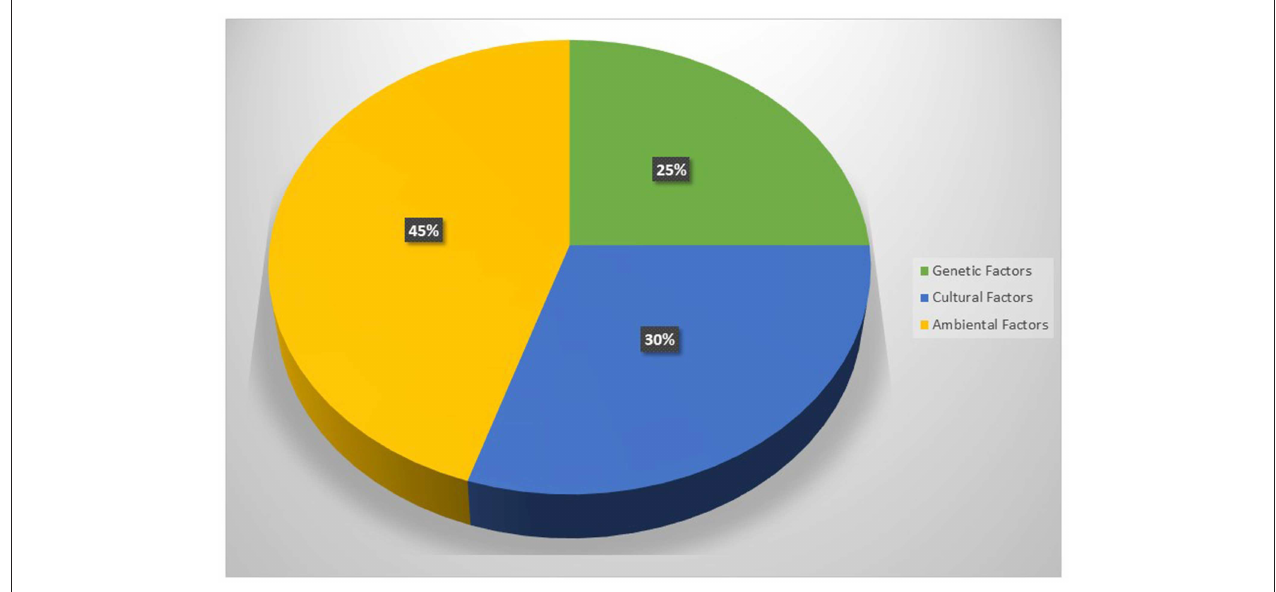
FIGURE 1 | The main causes of